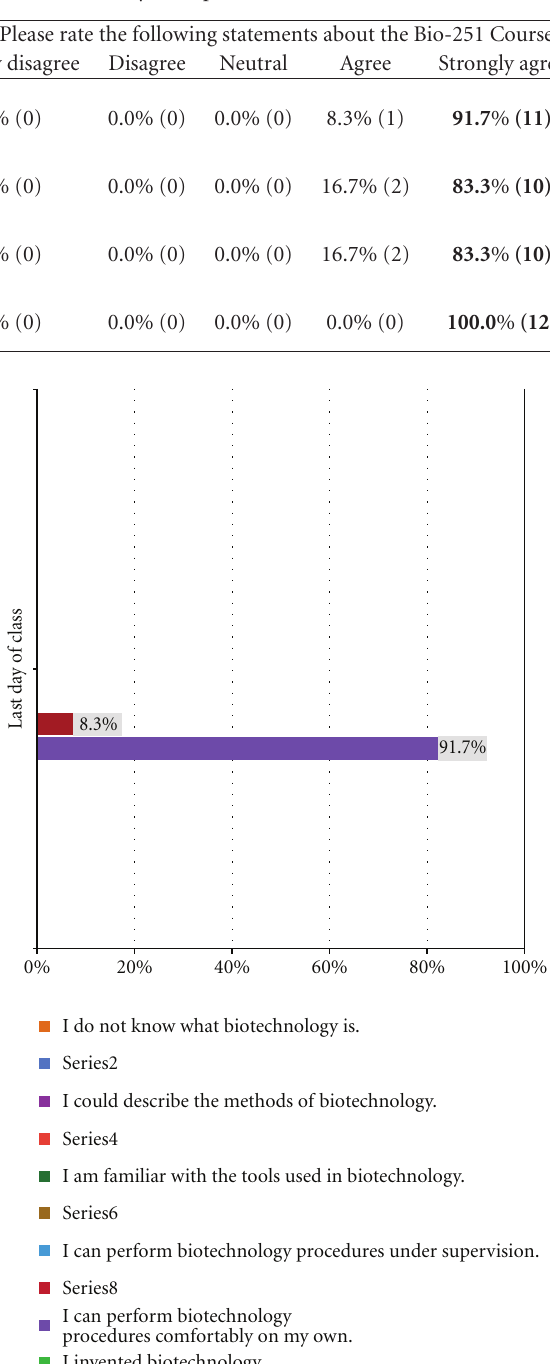
the fundamental processes involving prokaryotic